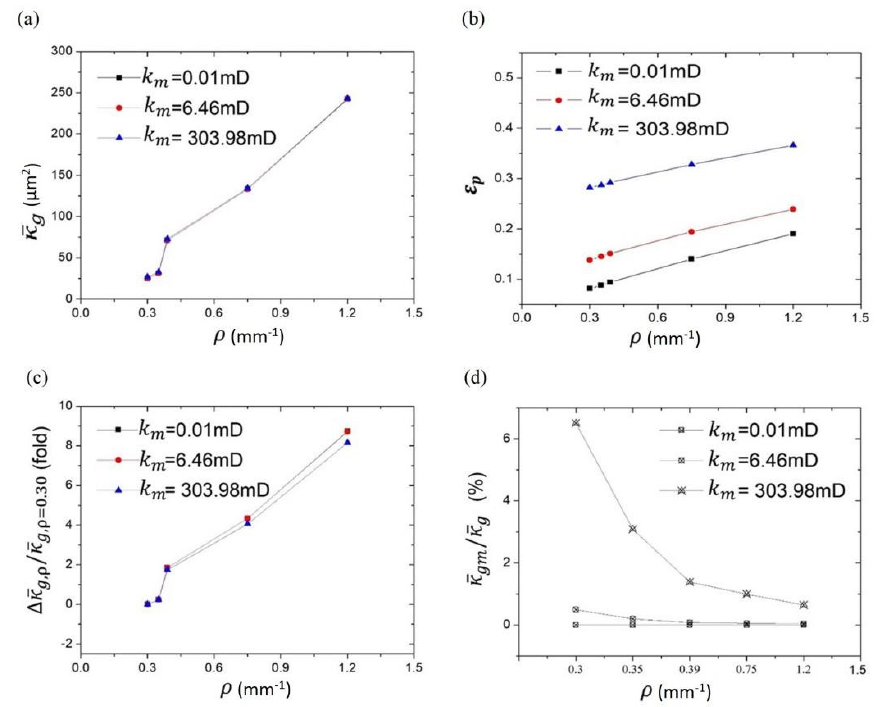
Figure 10. Variations of κ g ( a ), ε p ( b ), ∆ κ g , ρ / κ g , ρ = 0.30 ( c ), and κ gm / κ g ( d ) with fracture density ρ for different rocks. The horizontal axis in each subfigure denotes the fracture density ρ , while the vertical axis represents the ratio of the gas permeability variation ∆ κ g , ρ = κ g , ρ − κ g , ρ = 0.30 in ( c ), which is the change of gas permeability with increasing fracture density to the value of rocks with ρ = 0.30, κ g , ρ = 0.30 , i.e., ∆ κ g , ρ / κ g , ρ = 0.30 = ( κ g , ρ − κ g , ρ = 0.30 ) / κ g , ρ = 0.30 . The vertical axis represents the ratio of the matrix contribution κ gm / κ g in ( d ), which is the gas permeability of matrix domains κ gm to the total gas permeability of rocks κ g . Note: The numerical results at each point represent the average values calculated from three models with identical fracture